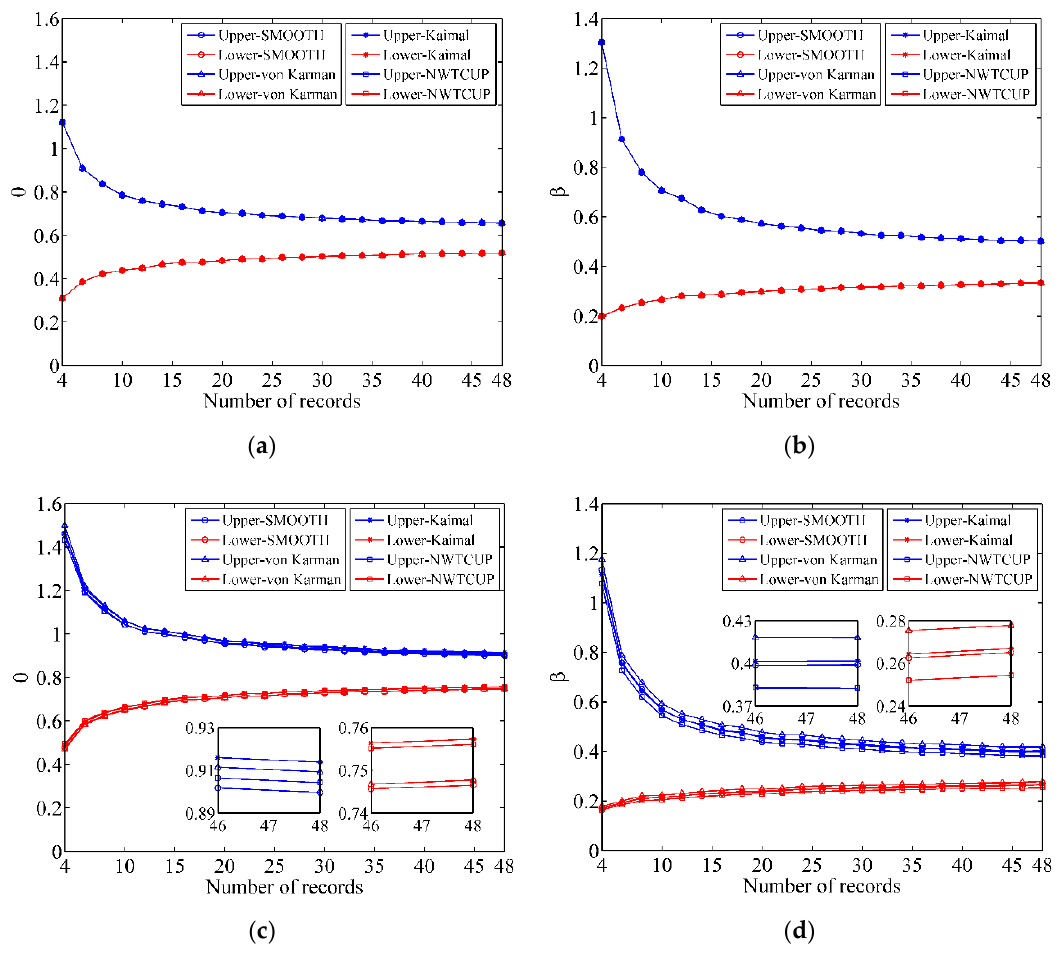
Figure 12. The comparison of the lower and upper 95% confidence interval for estimated and β between four wind spectra with a different number of records: ( a , b ) for the parked condition, and ( c , d ) for the normal operation condition. Table 2. Sufficient number with different wind spectrum for estimated θ and β